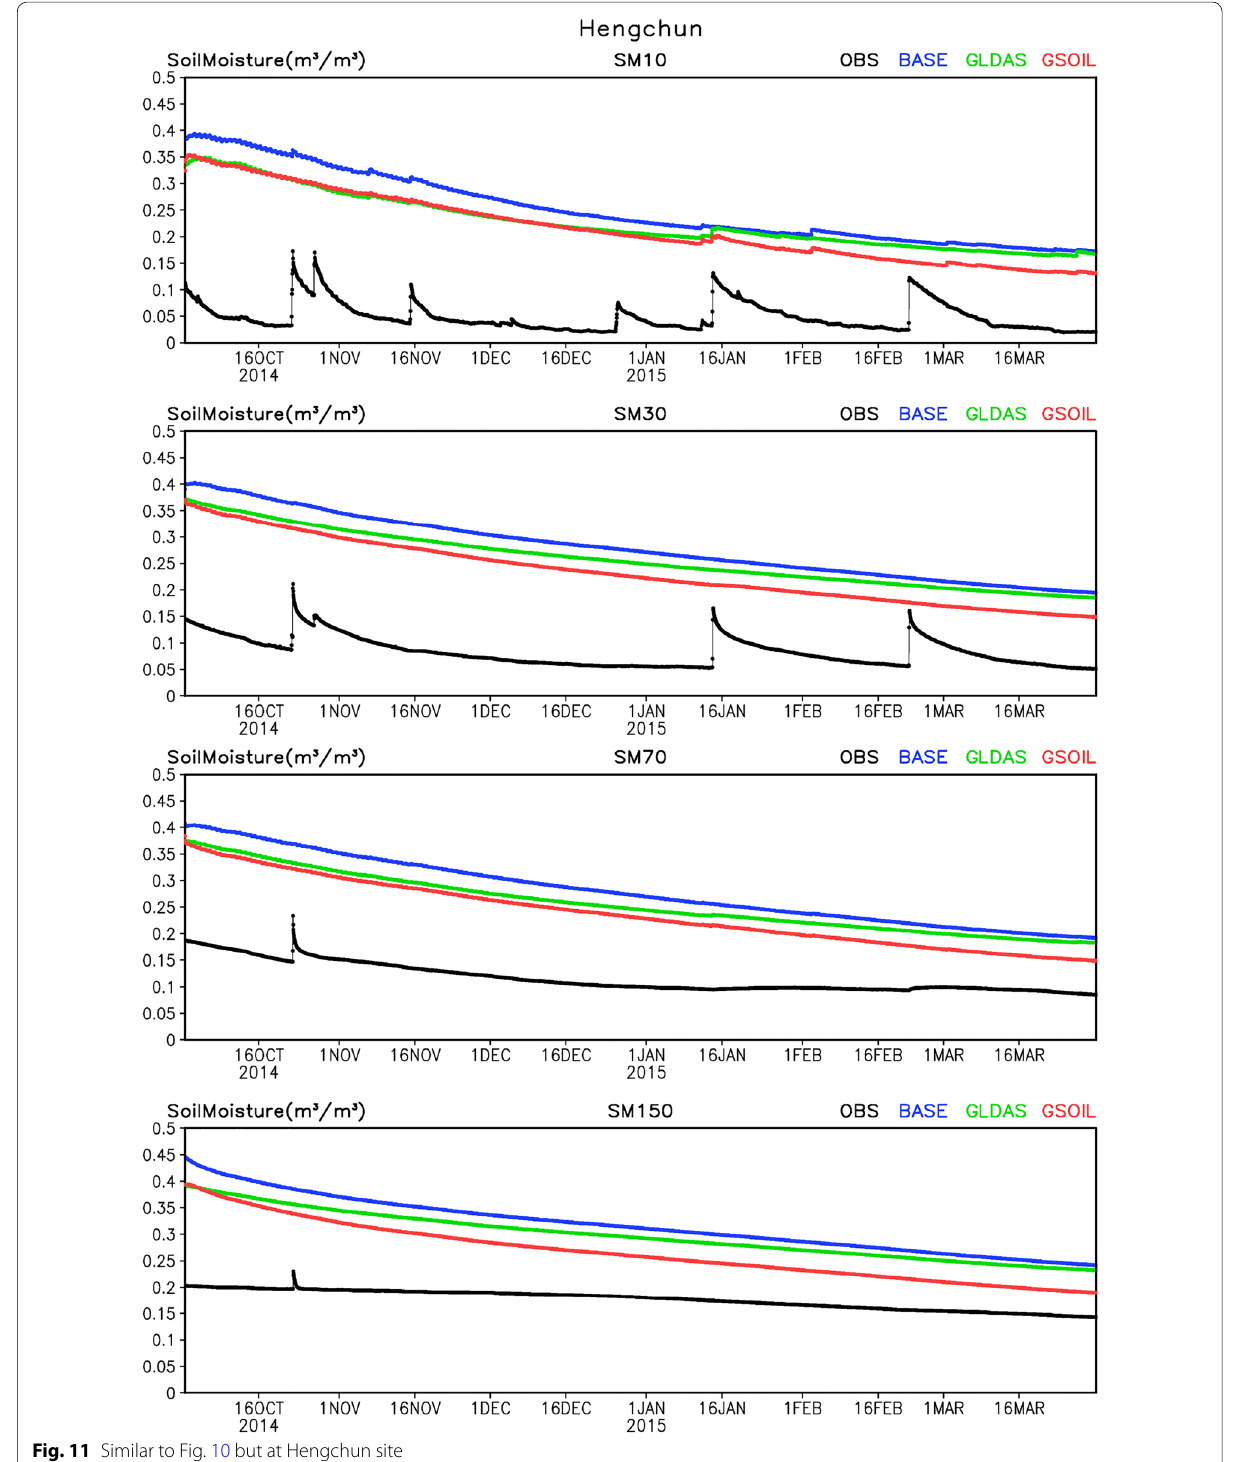
Fig. 11 Similar to Fig. 10 but at Hengchun